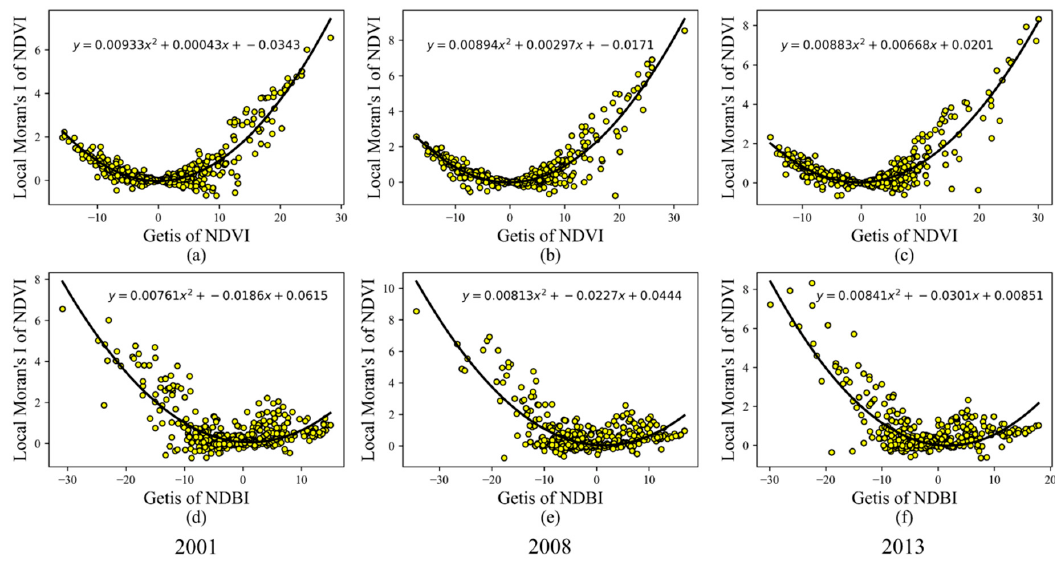
Figure 6. Scatterplots of the local Moran’s I with G of NDVI (a–c) and G of NDBI (d–f) for the three years.